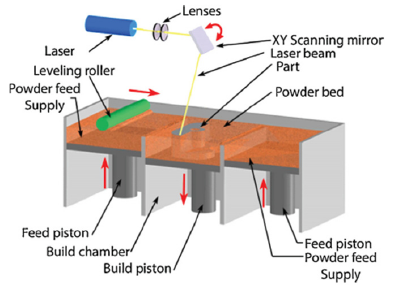
Figure 1. Schematics of additive manufacturing (AM) by selective laser melting (SLM). Reproduced with permission from [59], Elsevier, 2017.